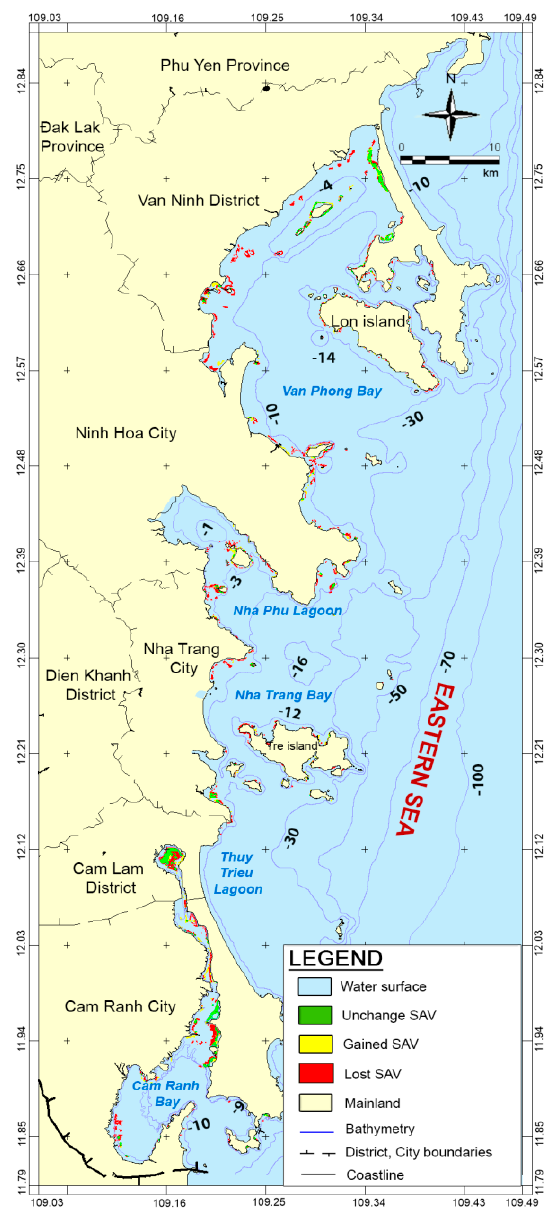
Figure 11. SAV change map in the Khanh Hoa coastal area for the period 2008–2018. Estimates were developed using data from Landsat-5 (2008) and Landsat-8 (2018).